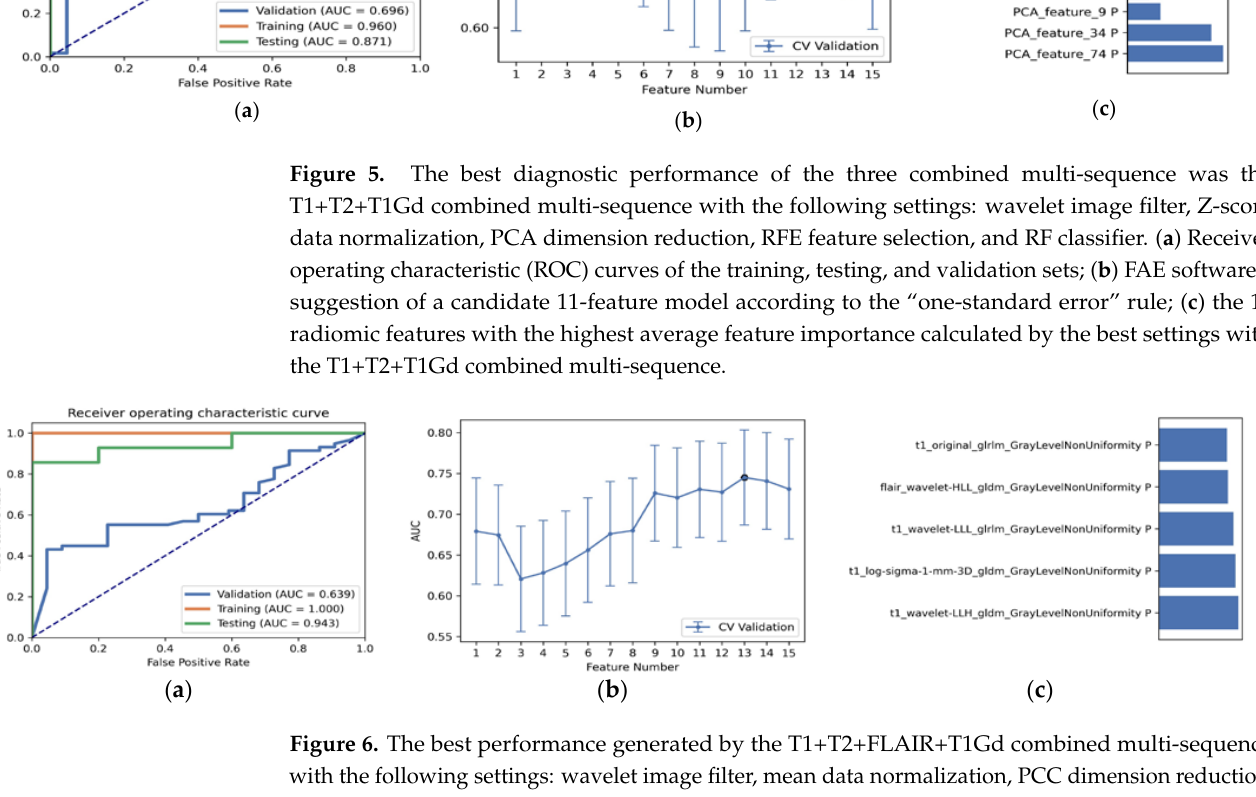
Figure 6. The best performance generated by the T1+T2+FLAIR+T1Gd combined multi-sequence with the following settings: wavelet image filter, mean data normalization, PCC dimension reduction, ANOVA feature selection, and RF classifier. ( a ) Receiver operating characteristic (ROC) curves of the training, testing and validation sets; ( b ) FAE software’s suggestion of a candidate 5-feature model according to the “one-standard error” rule; ( c ) the 5 radiomic features with the highest average feature importance calculated by the best settings with the T1+T2+FLAIR+T1Gd combined multi-sequence.